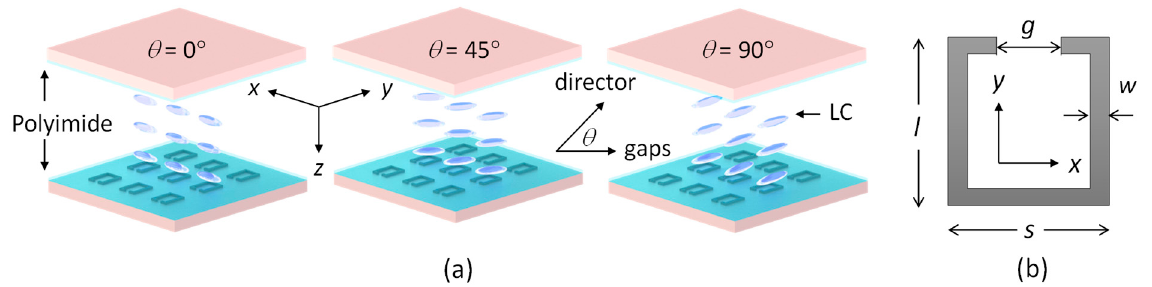
Figure 1. ( a ) Schematic configuration of liquid crystal (LC) cells that are coated with terahertz metamaterials. θ is an angle between the director of the LC and the gaps of the split-ring resonators (SRRs). ( b ) Dimensions of SRR.